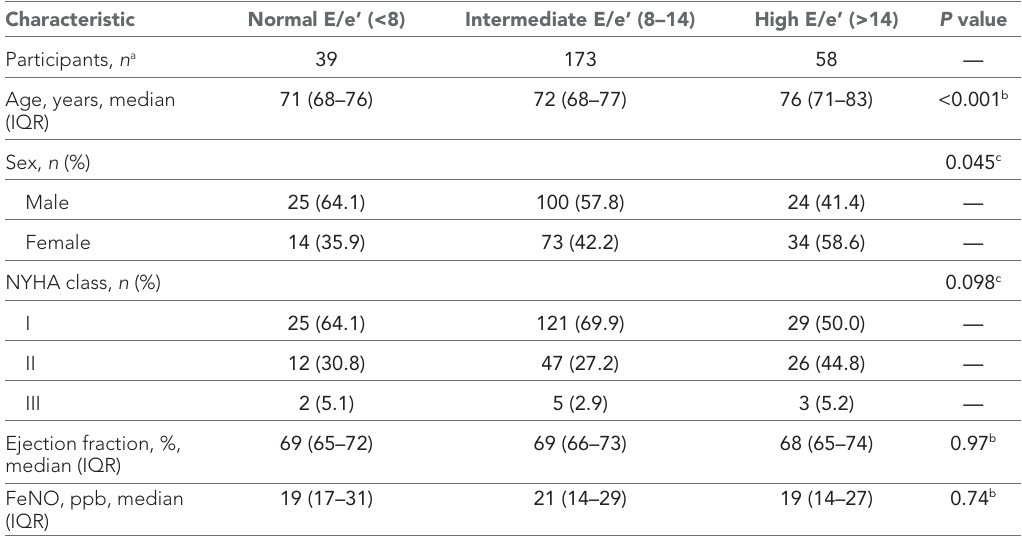
Table 2 Clinical characteristics of the OxVALVE subset stratified according to E/e’ ratio